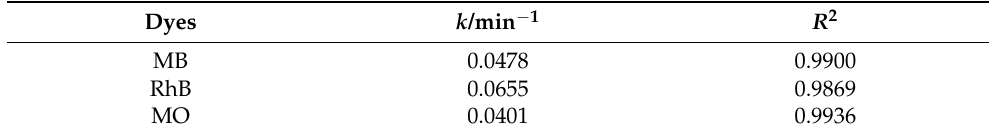
Figure 7. Degradation results of different dyes by TiO 2 -6%RGO ( a ) and its first-order kinetic analysis ( b ). Table 4. Kinetic parameters of different dye degradation by TiO 2 -RGO.